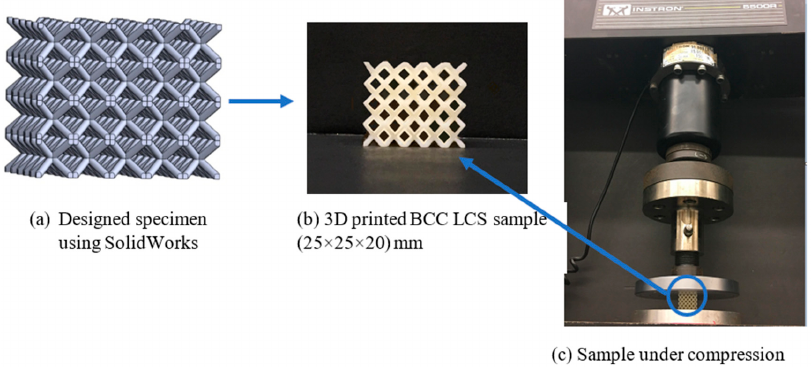
Figure 11. Experimental procedures, ( a ) sample design in SolidWorks; ( b ) sample fabrication using 3D printing; and ( c ) compression test.